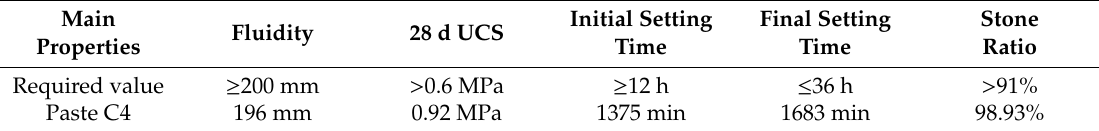
Figure 3. Fresh and mechanical properties of backfill pastes with different BHG alternative to NS: ( a ) fluidities; ( b ) stone ratios and water-separation ratios; ( c ) setting times; ( d ) 7 d and 28 d UCSs. Table 6. The performance requirements of the grosuting material for goaf backfill [19,21–24,33,34].